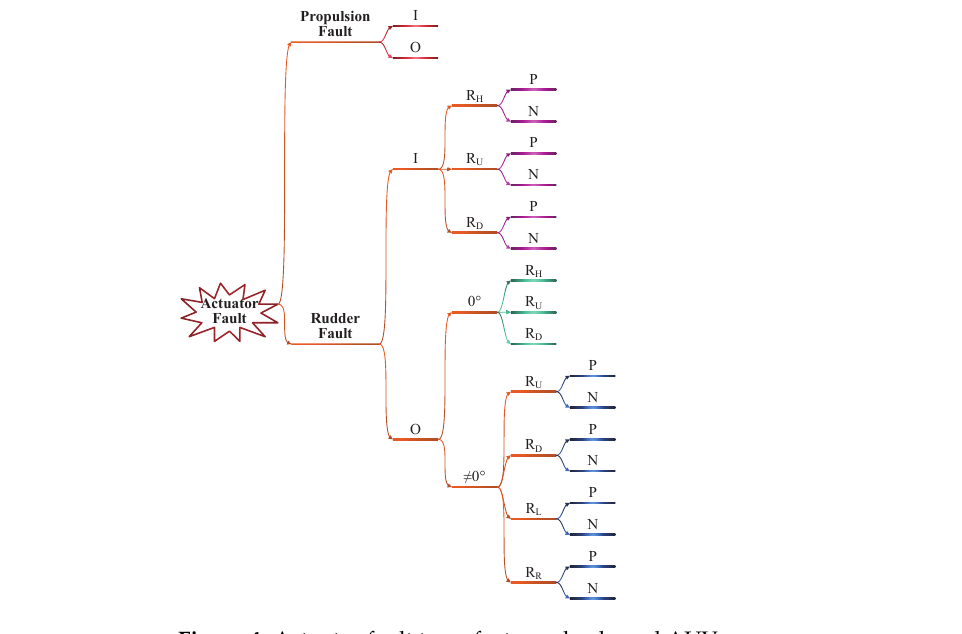
Figure 4. Actuator fault tree of a torpedo-shaped